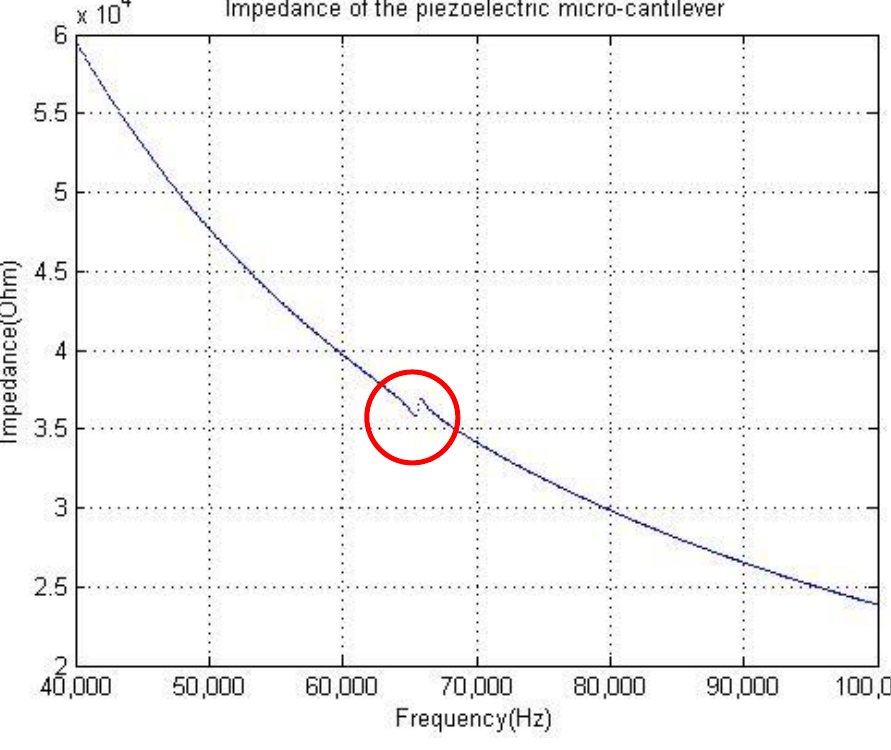
Figure 2. Impedance of the piezoelectric